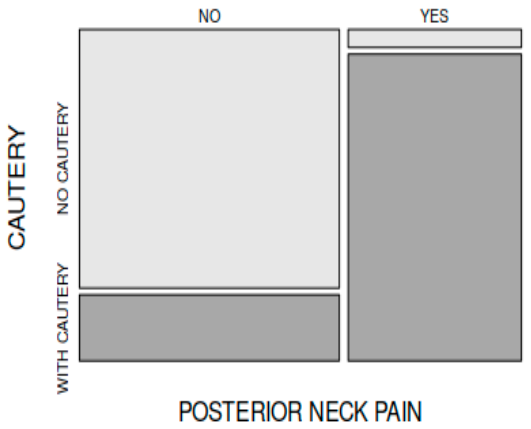
Figure 5. Incidence of posterior neck pain was significantly higher in patients in group A (electro- cautery group).